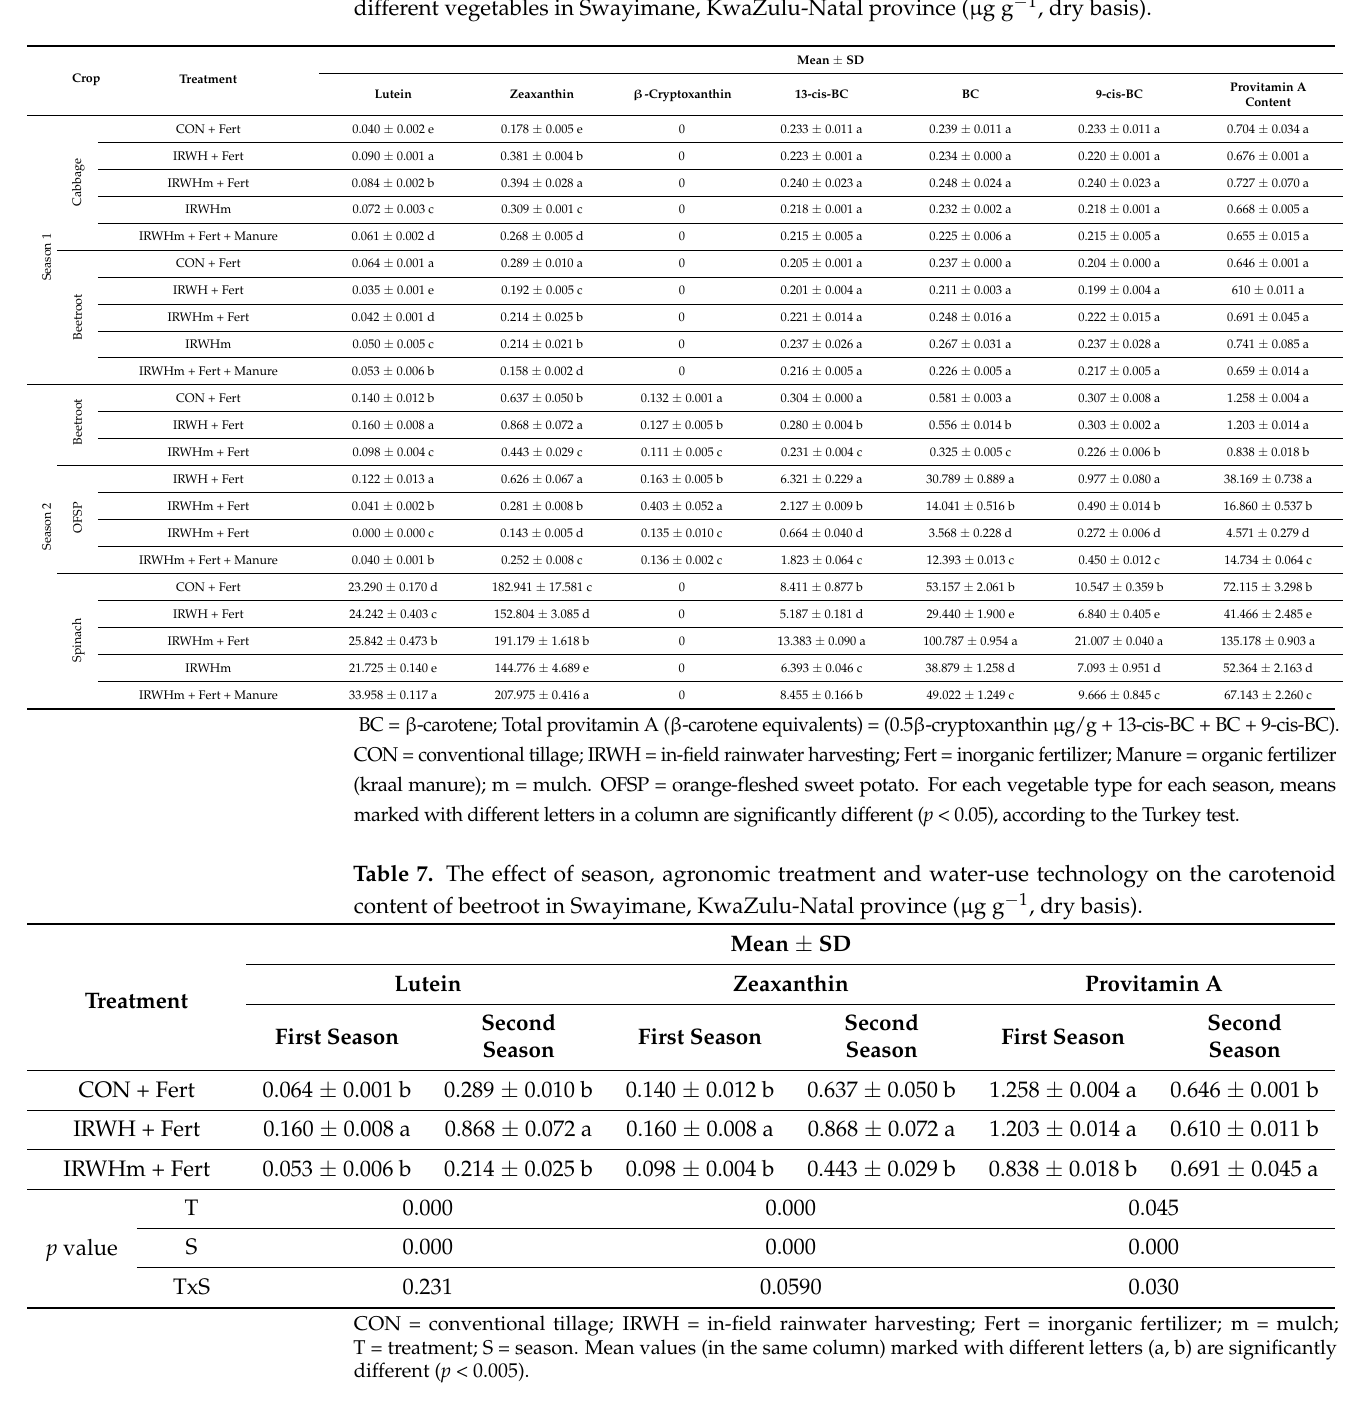
Table 6. Effect of agronomic treatment and water-use technology on the carotenoid content of different vegetables in Swayimane, KwaZulu-Natal province ( µ g g − 1 , dry basis).